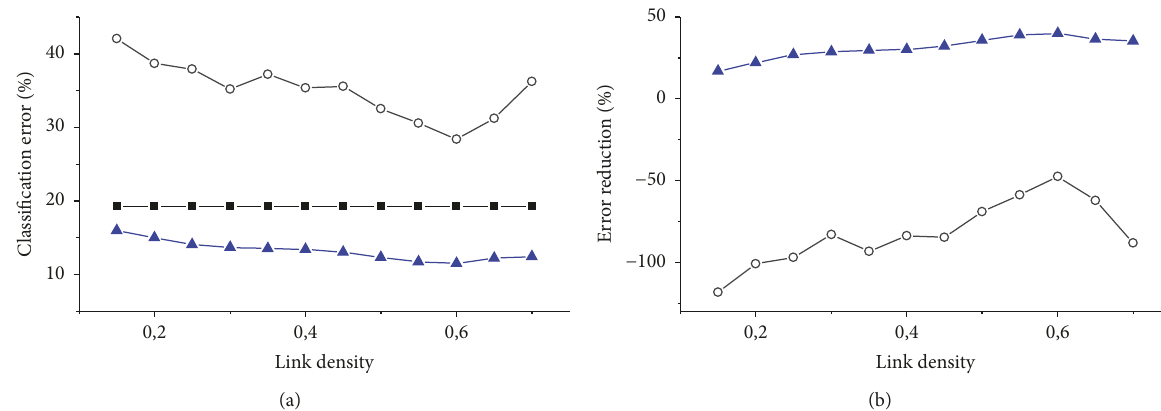
Figure 2: (a) Classification error as a function of the link density of the parenclitic networks. Black squares, black circles, and blue triangles, respectively, represent the error for the classification for the original raw features, for the classification using parenclitic features alone, and for the classification with all features. (b) Error reduction, in percentage, when using only parenclitic features (black circles) and the full set of features (blue triangles), with respect to the use of the raw data